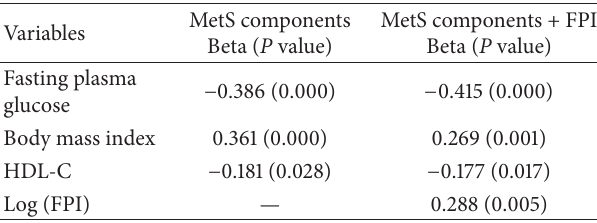
Table 4: Multiple linear regression of the associated factors with log (first-phase insulin secretion) in the 2 equations.